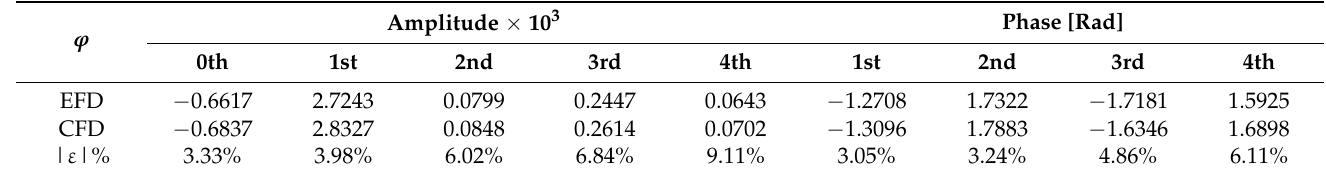
Table 22. Harmonic amplitudes and phases of roll for the FRxz ϕθ quartering waves scenario.